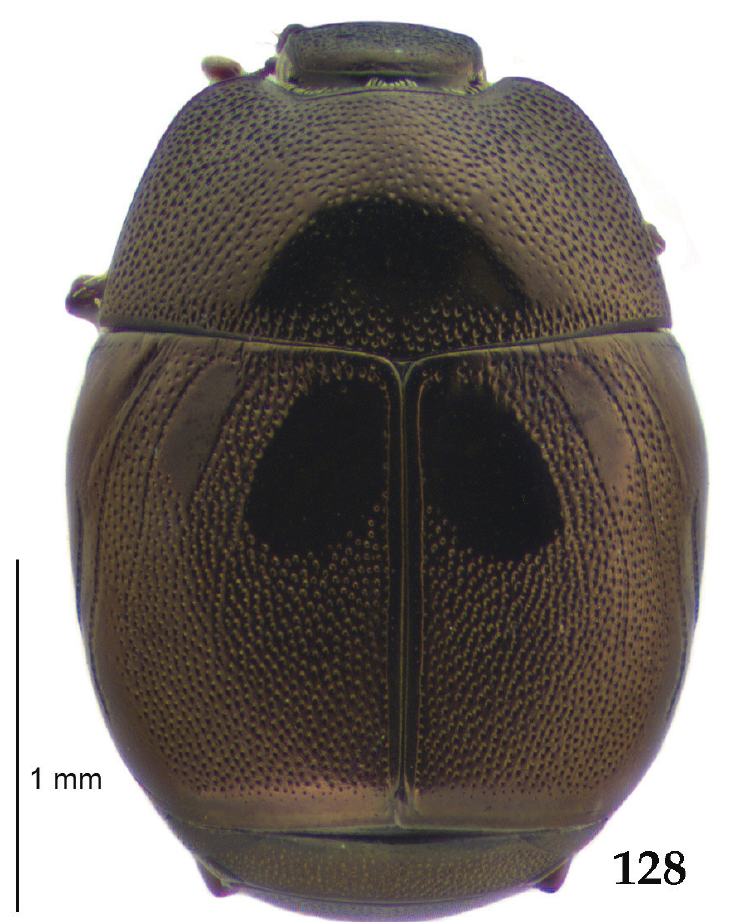
Figure 128. Hypocaccus ( Nessus ) interpunctatus interpunctatus (Schmidt, 1885) habitus, dorsal view. gusa” label like the lectotype, followed by: “Zool. Mus / Berlin” (printed); followed by: “Saprinus / interpunctatus Schmidt / Coll. Schmidt-Bickhardt” (printed); followed by: “ ♂ ” (written); followed by: “PARALECTOTYPUS / Hypocacculus (Nessus) / inter- punctatus (Schmidt, 1885) / Vienna & Colla des., 2003” (ZMHUB). Additional material examined. AUSTRALIA. Western Australia: 1 spec., Dardanup, 1.ii.1979, G. Hall (howden trap) (ANIC); 69 specs., 15 km S Bussel- ton, 4.xi.1982, G.P. Hall (ANIC); 30 specs., ditto, but 19.i.1983 (ANIC); 46 specs., ditto, but 9.viii.1983 (ANIC); 1 spec., ditto, but 13.viii.1983 (ANIC); 11 specs., ditto, but 16.vi.1983 (ANIC); 29 specs., ditto, but 12.i.1983 (ANIC); 25 specs., ditto, but 13.i.1983 (ANIC); 26 specs., ditto, but 27.i.1983 (ANIC); 2 specs., dit- to, but 27.x.1982 (ANIC); 2 specs., ditto, but 21.x.1982 (ANIC); 4 specs.,